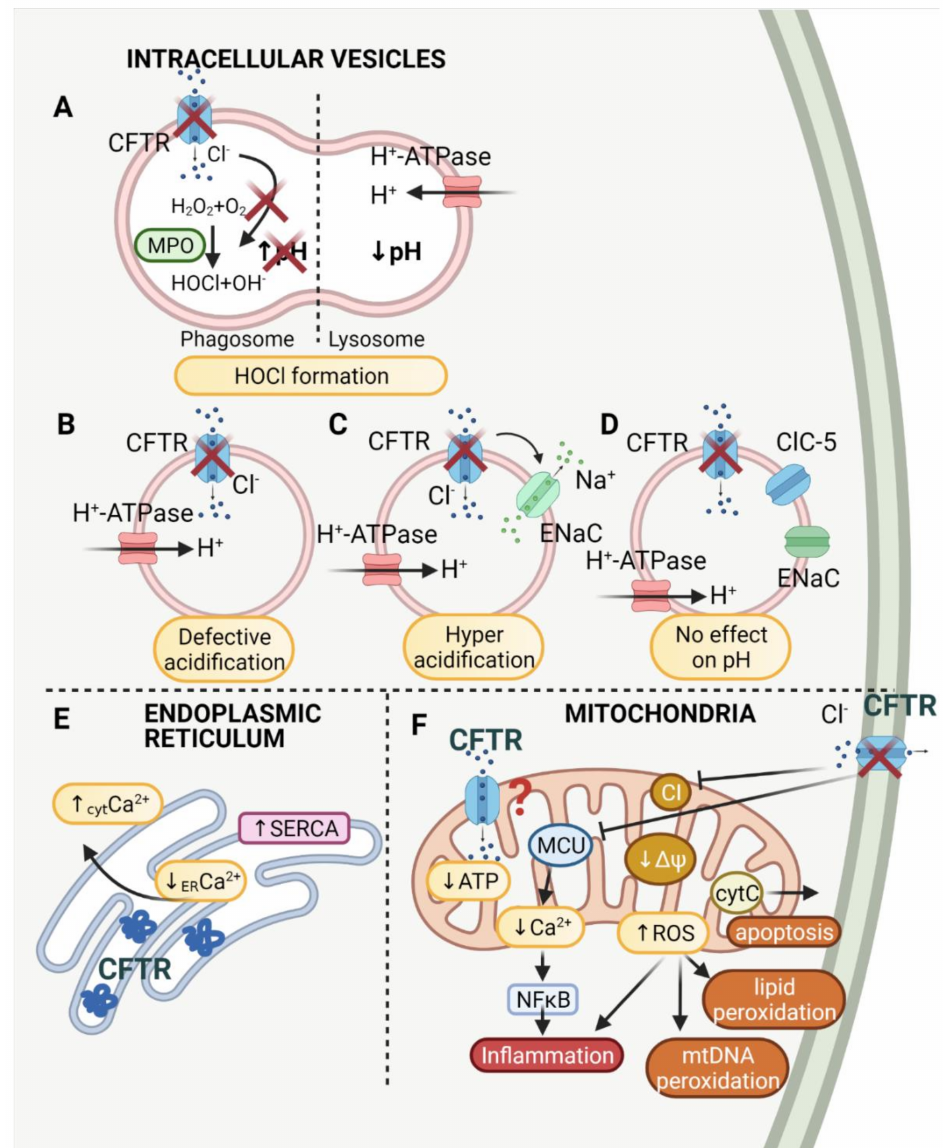
Figure 1. Summary of CFTR role in the intracellular organelles. ( A – D ) show the effect of CFTR impairment on intracellular vesicles. In phagosomes ( A ) of CFTR-depleted cells HOCl formation from Cl − , O 2 and H 2 O 2 by myeloperoxidase (MPO) is impaired. In healthy cells the process results in a phagosomal pH increase which is compensated by low pH of lysosomes fusing with phagosomes to form phagolysosomes. Changes in pH of other intracellular vesicles (lysosomes, Golgi) varies. There are three different pathways indicated. ( B ) CFTR malfunction may lead to defective acidification due to a deficiency in the counter anion transport of Cl − , required for proper H + − ATPase function and low pH maintenance. ( C ) Another mechanism of CFTR malfunction involves the lack of CFTR inhibitory effect on endothelial sodium channel (ENaC), which promotes outward sodium cation transport and results in hyperacidification. ( D ) No effect of CFTR on vesicle pH indicates other channels involved in proper acidification such as ClC-5. ( E ) In cystic fibrosis there is increased concentration of misfolded CFTR protein in the endoplasmic reticulum, which causes increased SERCA activity and the release of Ca 2+ from ER to cytoplasm. ( F ) The presence of CFTR in mitochondria is poorly documented. The effect of plasma membrane CFTR depletion on mitochondria is associated with: complex I (CI) of electron transport chain inhibition, lower ATP production, a decrease in mitochondrial membrane potential ( ∆ ψ ), MCU inhibition and cytochrome c release. The consequence of MCU inhibition is Ca 2+ release and NF κ B activation, which leads to inflammation. Besides Ca 2+ , ROS generated by mitochondria of CFTR-depleted cells also mediate inflammation as well as mitochondrial DNA and lipid peroxidation. Created with